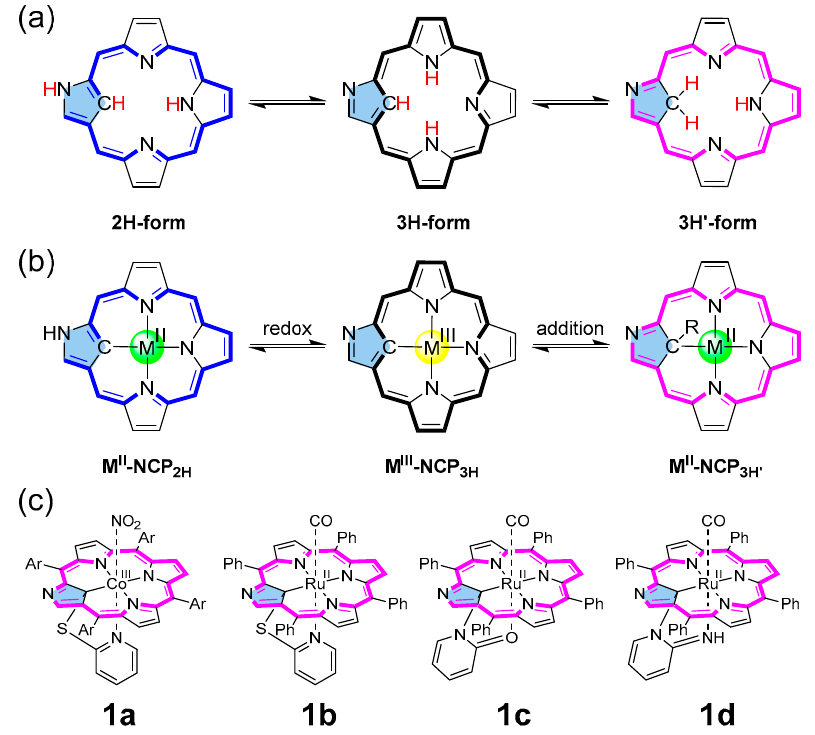
Figure 1. ( a ) Tautomeric forms of NCP, ( b ) redox conversion of metallo-NCP, ( c ) NCP metal com- plexes with tethered axial ligands (Ar = Phenyl or